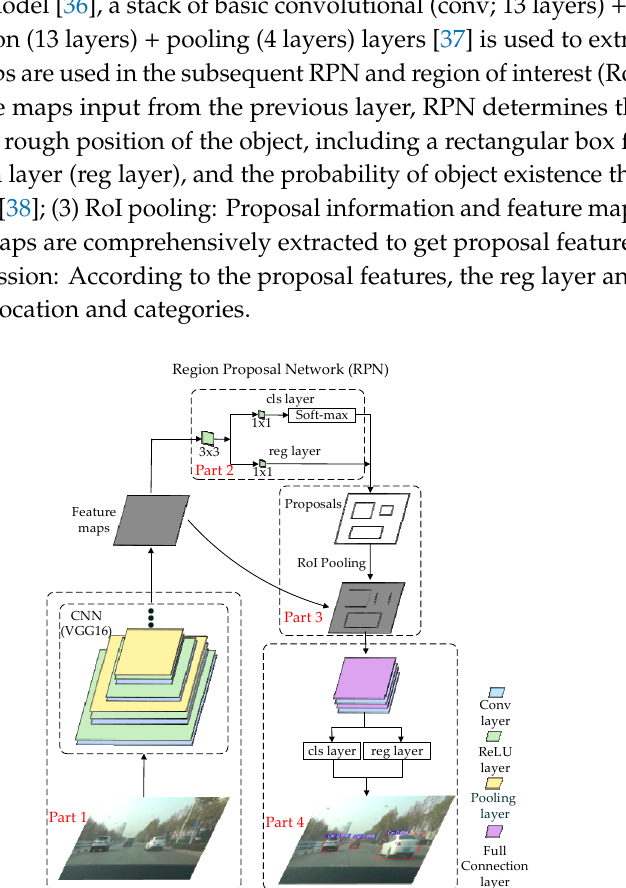
Figure 1. Schematic diagram of a faster region with a convolutional neural network (Faster R-CNN).